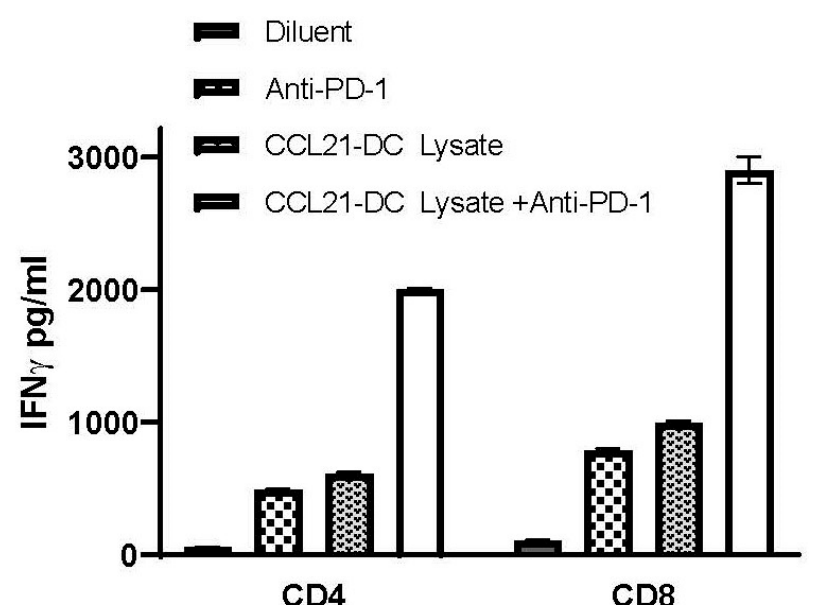
Figure 4. Anti-PD-1 plus CCL21-DC tumor antigen (Ag) vaccine therapy enhances dendritic cell (DC) activity in the TME. CD4 and CD8 T cells were purified from the spleens of mice following vaccination with DC tumor lysate vaccine. DCs from TME of (i) diluent control, (ii) anti-PD-1, (iii) CCL21-DC tumor lysate vaccine, and (iv) anti-PD-1 plus CCL21-DC tumor lysate vaccine were pulsed with MHC Class I K-Ras peptide (LVVVGADGV) or MHC Class II (MTEYKLVVVGADGVG) and co-cultured with splenic CD8 or CD4 T cells of the vaccinated mice at a ratio of 1:5 for 24 h. IFN γ secreted by T cells in the co-culture was determined by IFN γ -specific ELISA. In comparison to diluent control or monotherapy, anti-PD-1 plus CCL21-DC tumor lysate Ag induced the highest DC activity of presenting MHC Class I and MHC Class II K-RasG12D tumor peptides to T cells. Control peptide (FECNTAQAC)-pulsed DCs did not stimulate T cell IFN γ production (data not shown). Bars represent SE; p < 0.01 compared with diluent-treated control, p < 0.05 compared with monotherapy. Results are representative of a single experiment ( n = 4 mice / group). Purified NK cells were plated with tumor cells at the ratio of 5:1 for 24 h. Almar blue (20 µ L) was added for 4 h after 24 h, and the fluorescence was read. Bars represent SE. Results are representative of a single experiment (Figure 5B) ( n = 4 mice / group). Anti-CD4 and anti-CD8 led to > 95% depletion of the respective T cell populations. Results are representative of two experiments ( n = 10 mice /